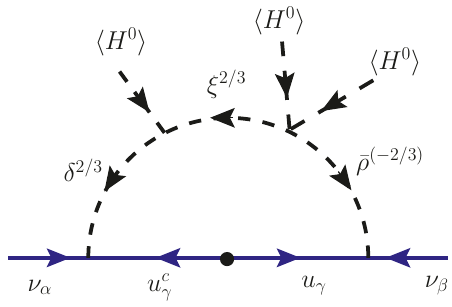
Figure 42 . Feynman diagram for neutrino mass generation in the extended one-loop LQ model with up-type quark chiral suppression in the loop. The (cid:1) L = 2 e(cid:11)ective operator is e